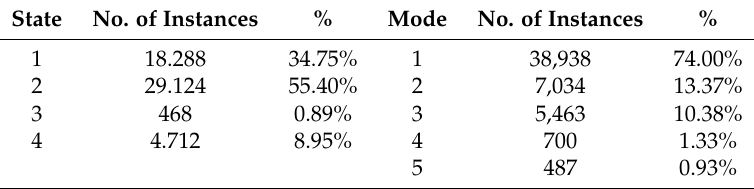
Table 2. Distribution of class values in the two classification problems. State No. of Instances % Mode No. of Instances